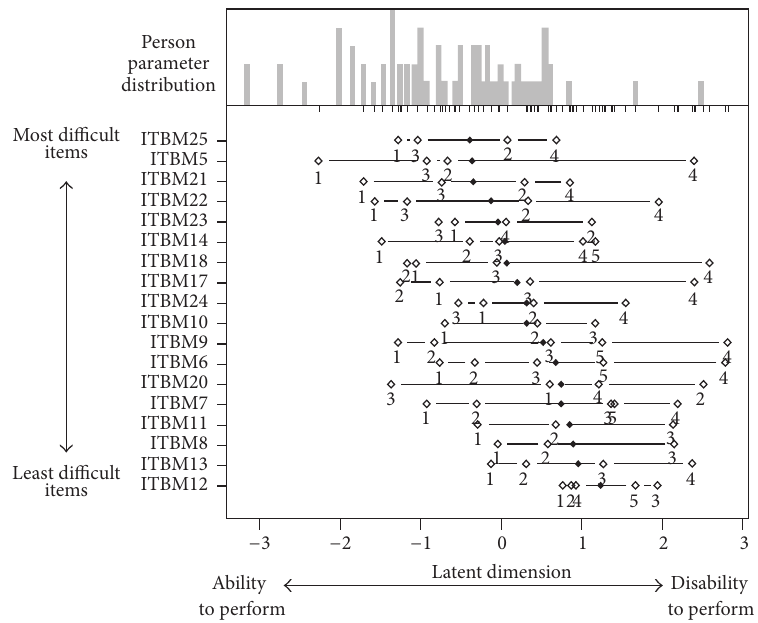
Figure 2: The Rasch person-item map displays the location of item (and threshold) parameters as well as distribution of person parameters along latent dimension. Difficult to easier items to perform are arranged from the top to bottom of 𝑦 -axis; less to higher visual ability is arranged on either side of midpoint on 𝑥 -axis. Subjects with the least visual ability (at the left side of 𝑥 -axis) have difficulty even with the easiest items; subjects with more visual ability (at the right side of 𝑥 -axis) have no difficulty performing any of the items. This figure shows that the items such as mental health, near activities, and dependency (located at the top of the 𝑦 -axis) required greater visual ability and were more difficult items to perform. At the other end, color vision, social functioning, and distance activities located at the bottom of the 𝑦 -axis required less visual ability and were less difficult items to